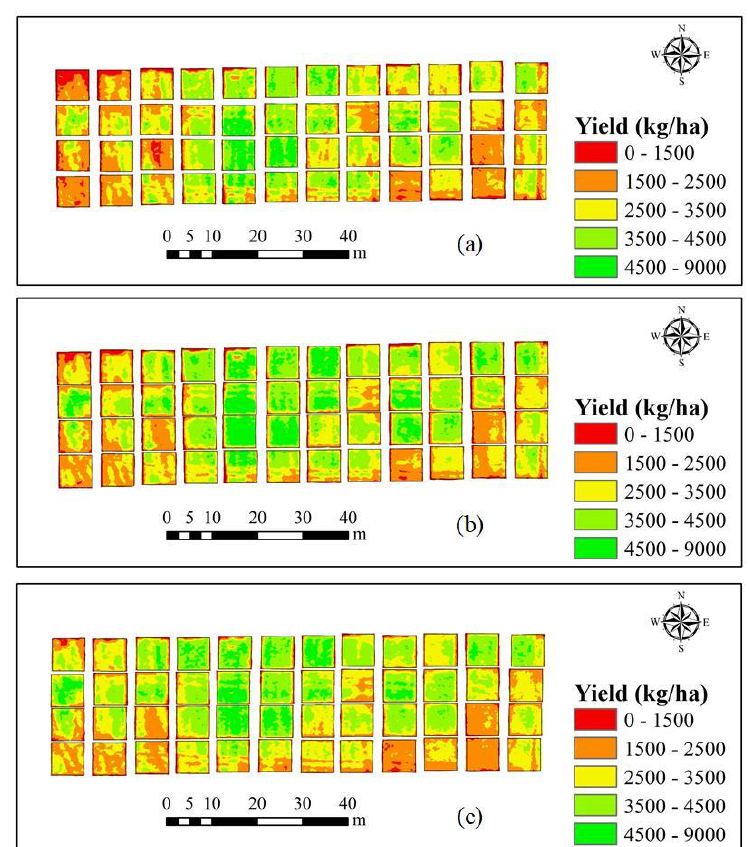
Figure 9. Maps showing the predicted yield of winter wheat in the 48 experimental plots obtained using PLSR and a combination of the SIs and H CSM . ( a ) Jointing stage, ( b ) flagging stage, and ( c ) flowering stage.